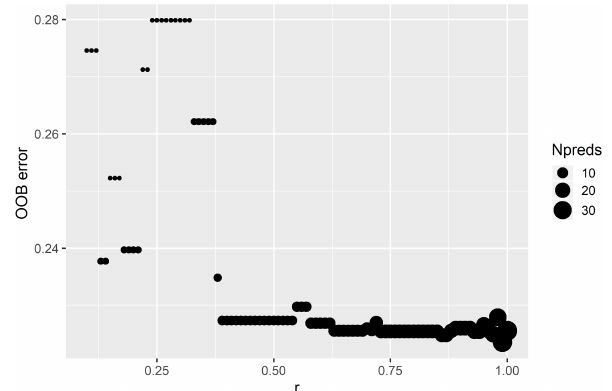
Figure 3. Influence of r value on the out-of-bag error of a random- forest model with default parameters. The size of the circles indi- cates the number of selected predictor variables (Npreds).